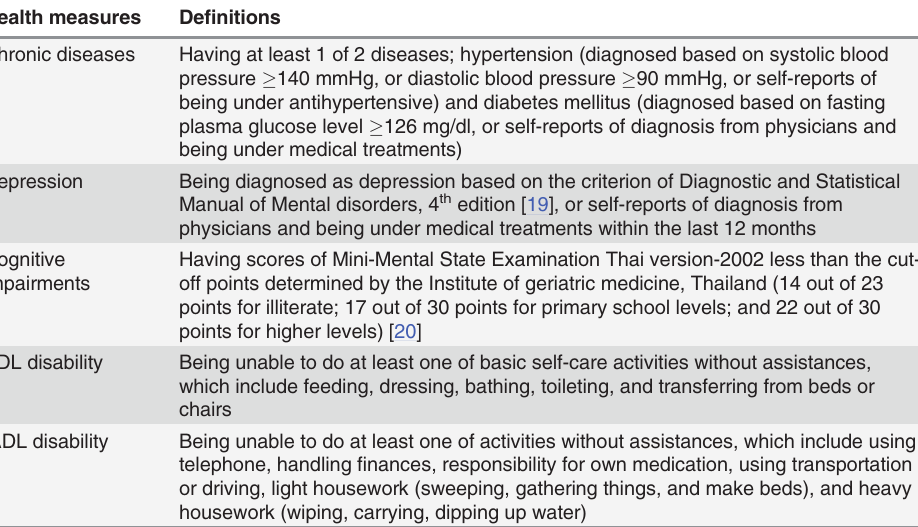
Table 1. Definitions of health